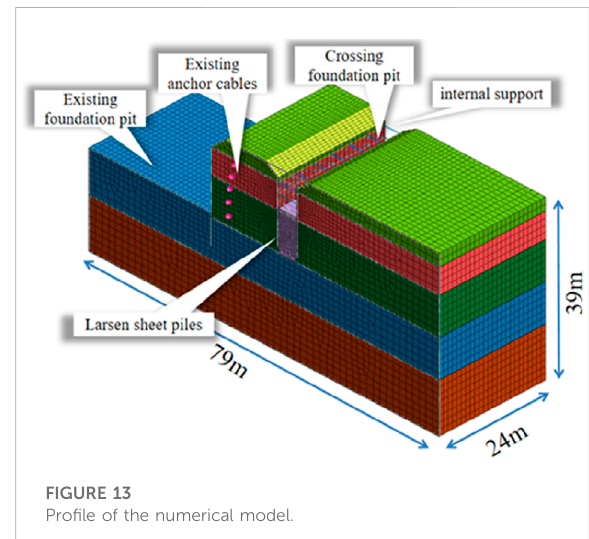
FIGURE 13 Pro fi le of the numerical